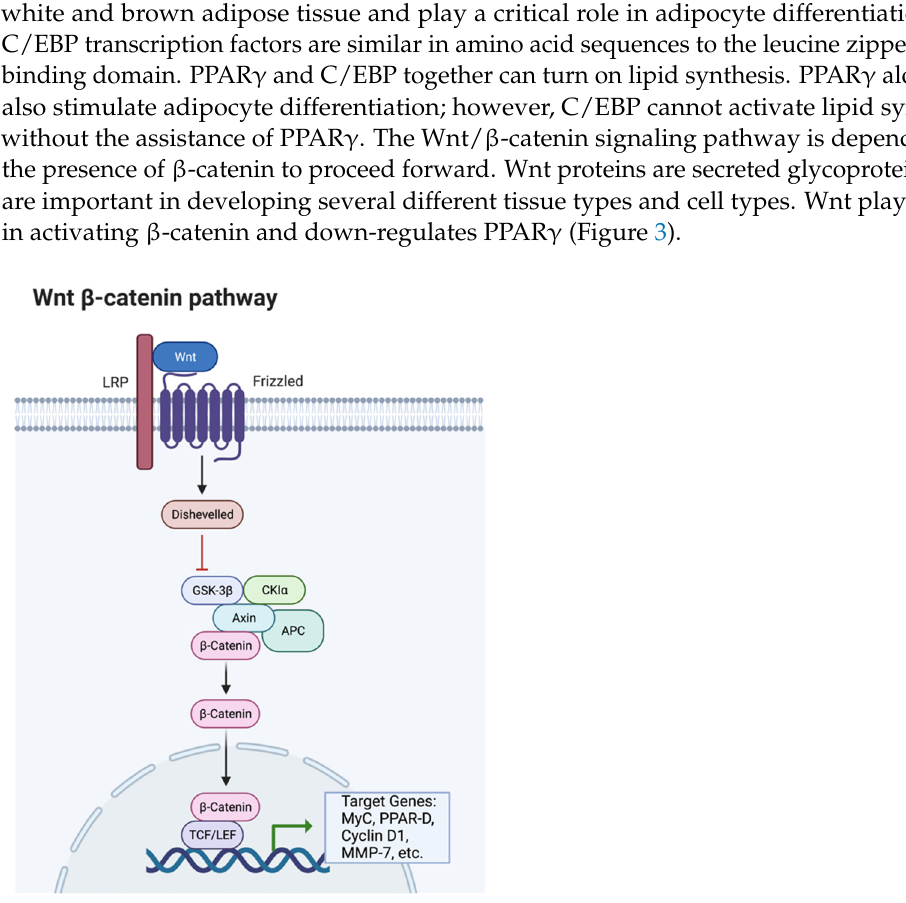
Figure 3. The Wnt/ β -catenin pathway. Produced in biorender and adapted from cellsignal.com , accessed June 13, 2022.